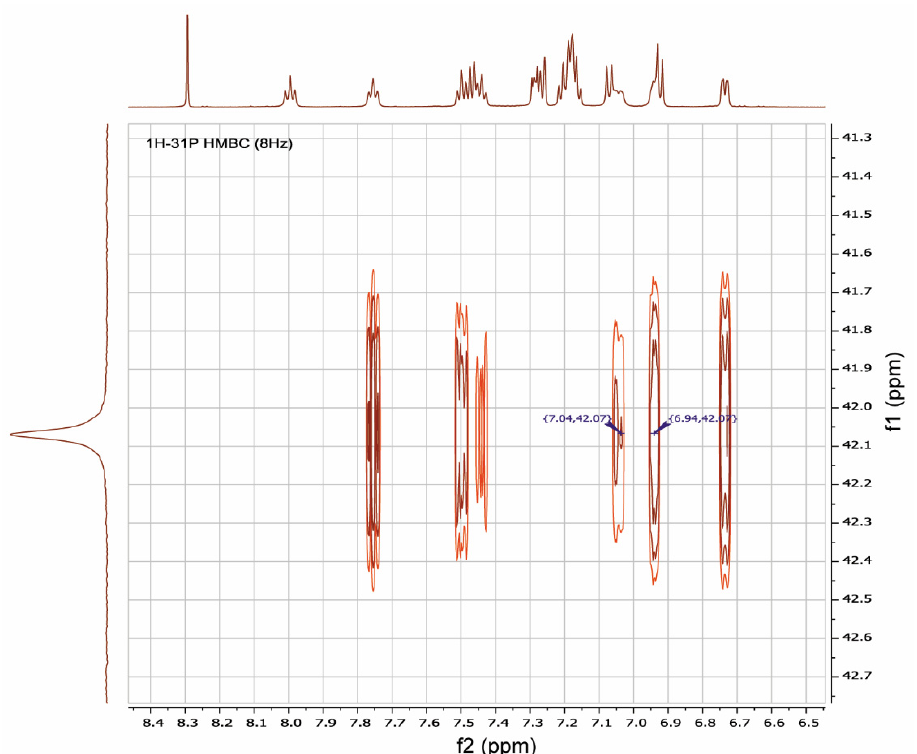
Figure 12. A fragment of 1 H- 31 P HMBC spectrum illustrating the key correlations of protons at 7.04 and 6.94 ppm of aminobiphenyl fragment with a phosphorus atom of RuPhos in RuPhos Pd G3 in DMSO- d 6 solution.